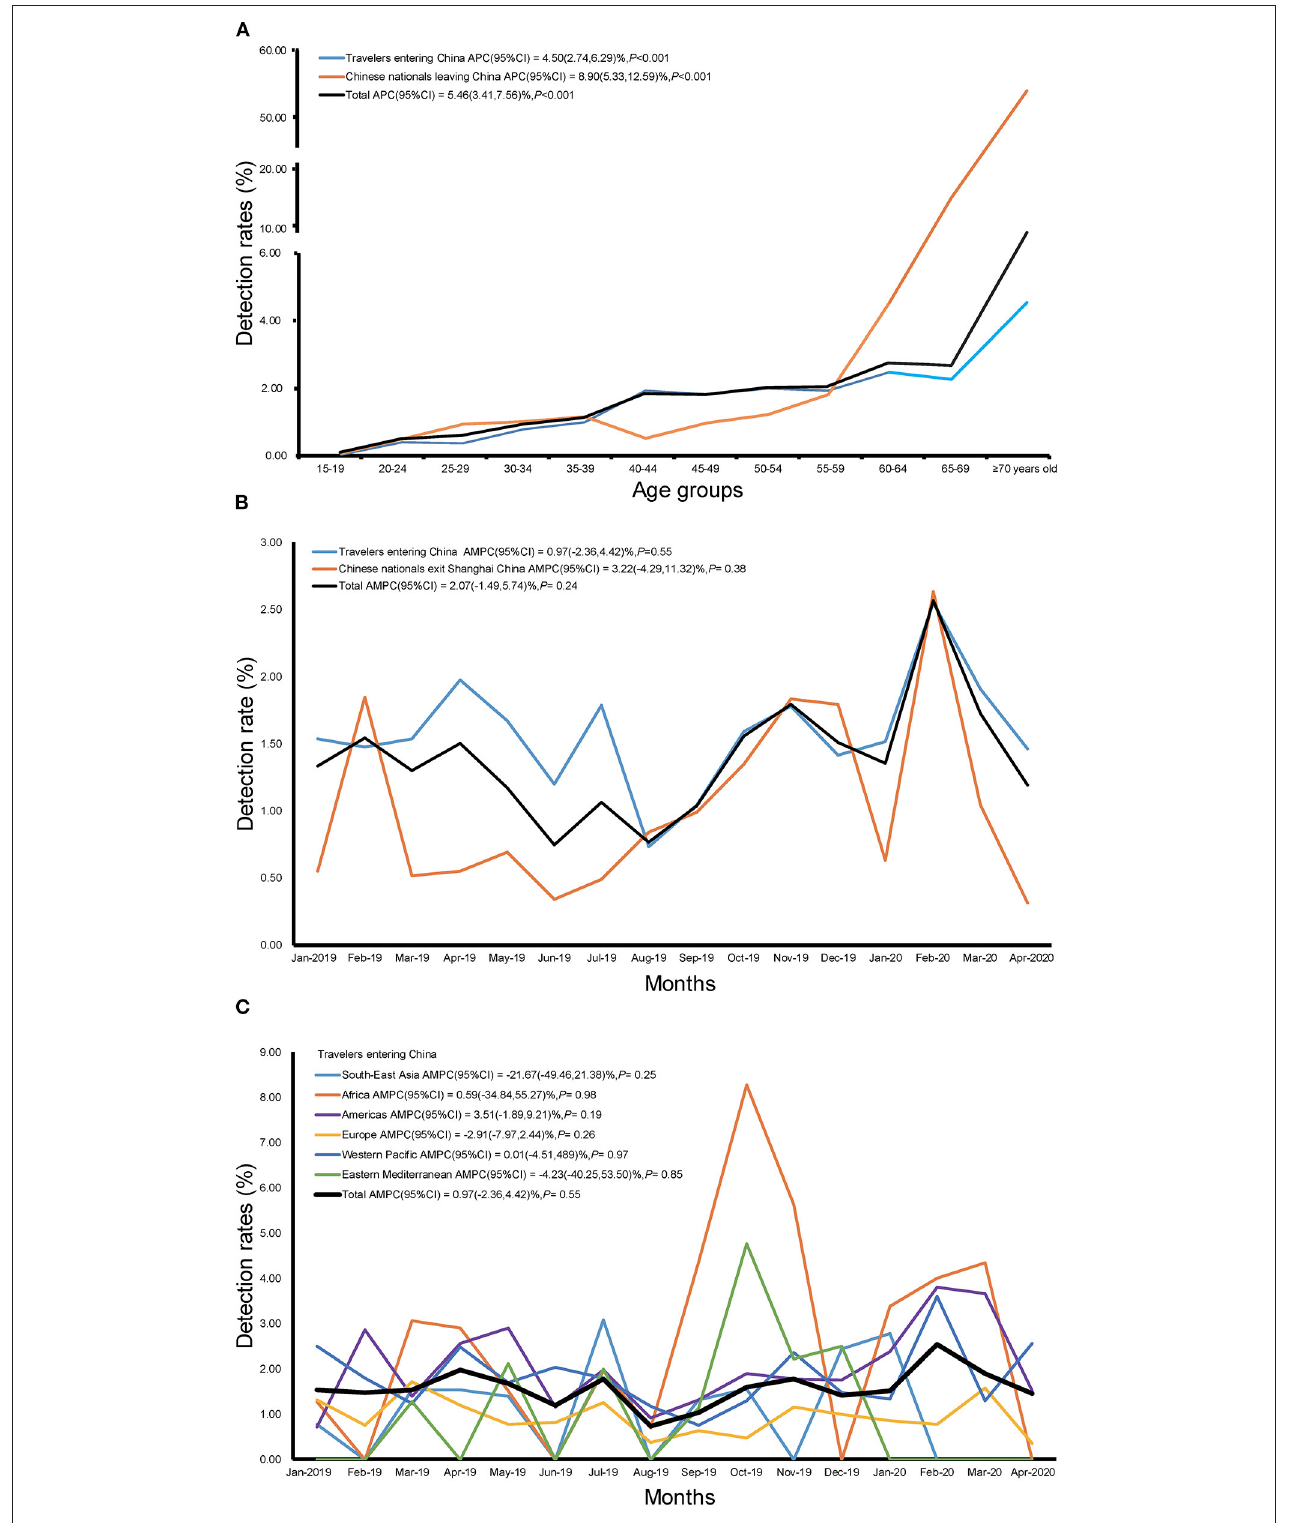
FIGURE 3 | Trend of detection rate of infectious diseases among travelers at Shanghai Port, China, Jan 2019–Apr 2020 (A) Age trends; (B) Time trends; (C) Time trends in each region.